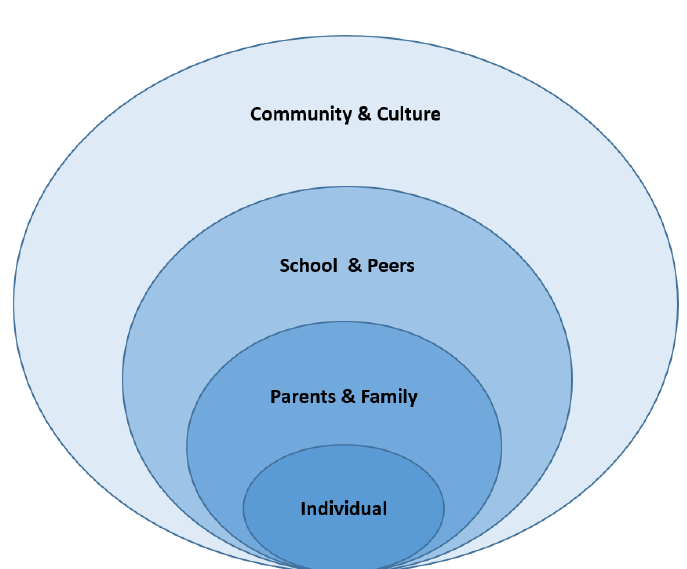
Figure 1. Modified socioecological systems theory (Adapted from Bronfenbrenner [29]).